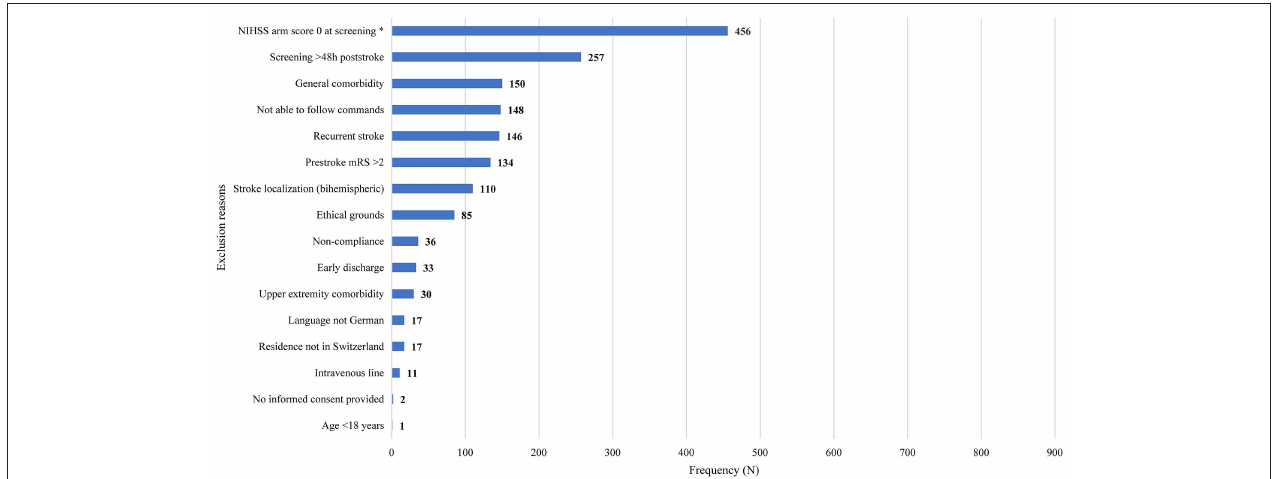
FIGURE 1 | Overview of exclusion reasons for non-eligible patients ( N = 814). Exclusion reasons arranged in descending order based on their prevalence. Stroke localization (bihemispheric) and recurrent stroke refer to the inclusion criterion “first-ever unilateral ischemic stroke.” The criterion “comorbidity” was divided into general comorbidity (e.g., Morbus Parkinson) and specific upper limb comorbidity (e.g., arthrosis of the hand, humerus fracture). Patients not residing in Switzerland could not be enrolled, as they would not be able to return for the follow-up visits. Four patients fulfilling the criteria could not be enrolled due to time constraints of researchers ( N = 3) or patient ( N = 1). h, hours; NIHSS, National Institutes of Health Stroke Scale; mRS, modified Rankin Scale; *One data point missing.